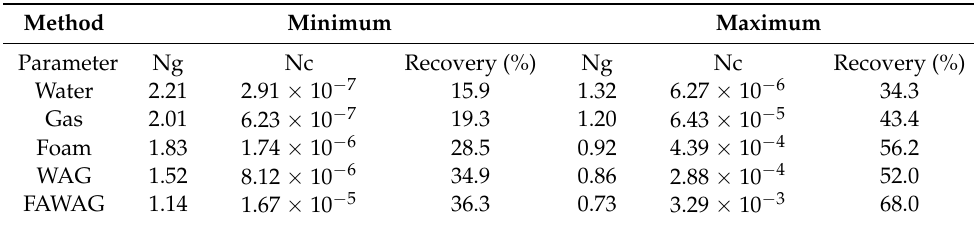
Table 4. Oil recovery of the different EOR methods.